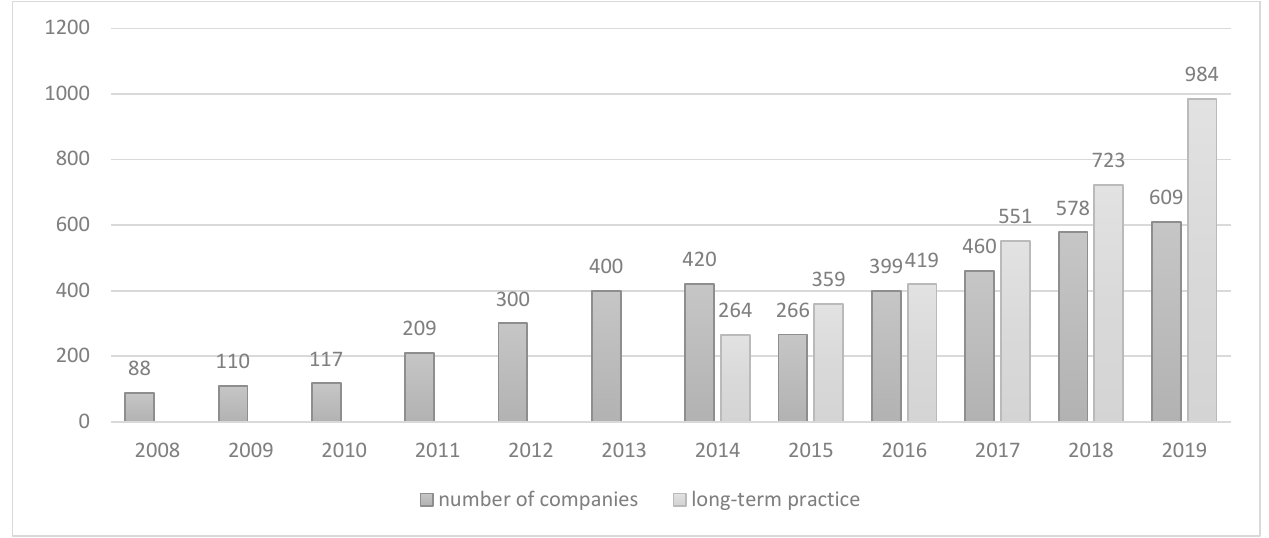
Figure 4. The number of enterprises in Poland voluntarily participating in the Responsible Business Forum ranking “Responsible Business in Poland Report”. Source: based on [23–34].